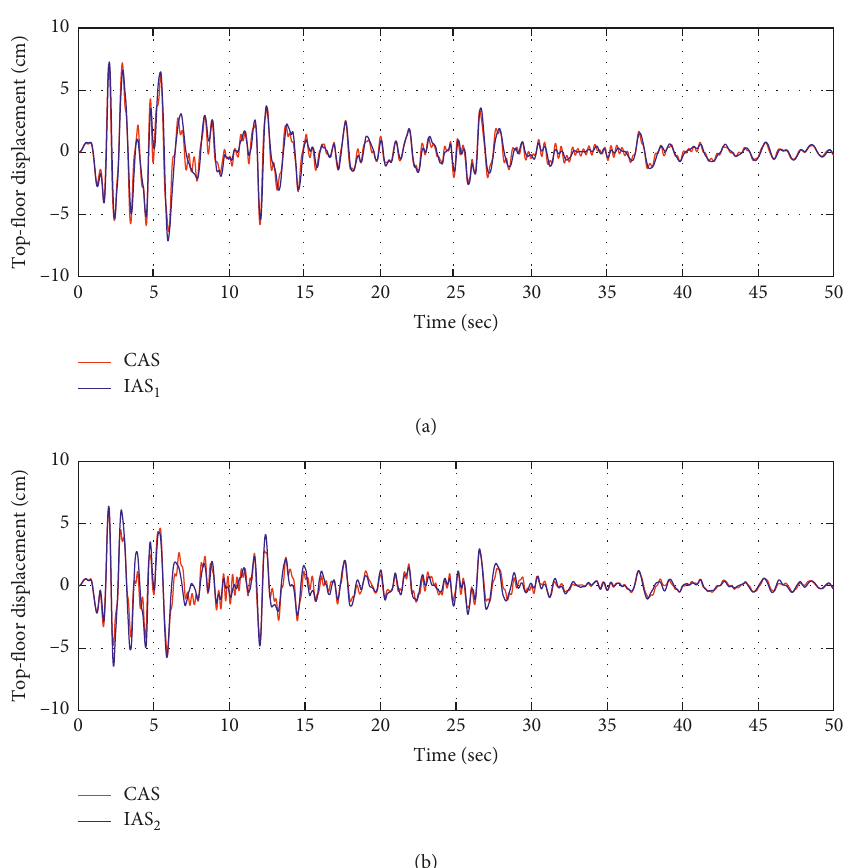
Figure 4: Comparative time-history curves of top-floor displacements between IAS and CAS against El Centro earthquakes. (a) Building 1. (b) Building